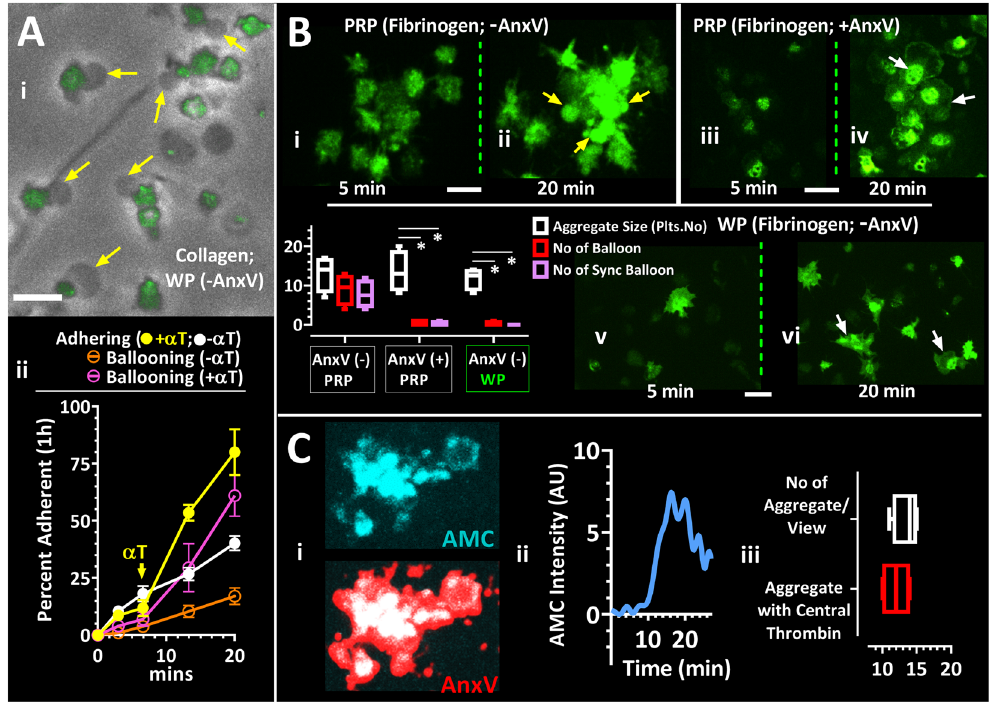
Figure 3. Thrombin mediates synchronised membrane ballooning in aggregating human platelets. ( A , B ) ( A ) Fluo-4-labelled washed platelets were allowed to adhere to collagen matrix in the presence of 1 mM extracellular calcium. Yellow arrows in A-i point to platelets induced to balloon by addition of thrombin. A-ii: time course of the percentage of adherent platelets that undergo ballooning, either with addition of α -thrombin (indicated as arrow with α T) or without thrombin addition. Related to Movie_S2. ( B ) Aggregate formation (defined as between 7–40 Fluo-4-labelled platelets in contact with each other) on a fibrinogen-coated surface in Rc- PRP (i-iv) or washed platelets (WP; v-vi). Platelets were pre-incubated with high concentration annexin-V (2%) in B-iii and B-iv. Yellow arrows in B-ii show ballooning platelet membranes. White arrows in B-iv and B-vi indicate lamellipodial spreading. Related to Movies_S3 and S4. The chart in B shows the number of platelets in aggregates, number of total balloons formed per aggregate and the number of balloons formed in a synchronised manner per aggregate. ( C ) C-i, shows extended focus image of fluorogenic thrombin substrate Z-Gly-Gly-Arg aminomethyl coumarin (ZGGR-AMC (cyan) alone and superimposed onto AnxV-stained platelet aggregate (red). C-ii, Fluorescence intensity vs time plot for fluorogenic thrombin substrate. C-iii, shows chart of number of aggregates compared with aggregates showing central thrombin generation per microscope view. Chart in B and Ciii show interleaved box plots with whiskers showing minimum to maximum values, median, and interquartile range. Data analysis was by Wilcoxon Signed Rank Test. * P < 0.05 was considered significant. Scale bar represents 5 µ m (A,B,C). Data were from 10–15 aggregates (of 7–40 platelets) per view; and 35 ± 5 aggregates were analysed for each of 5 donor blood